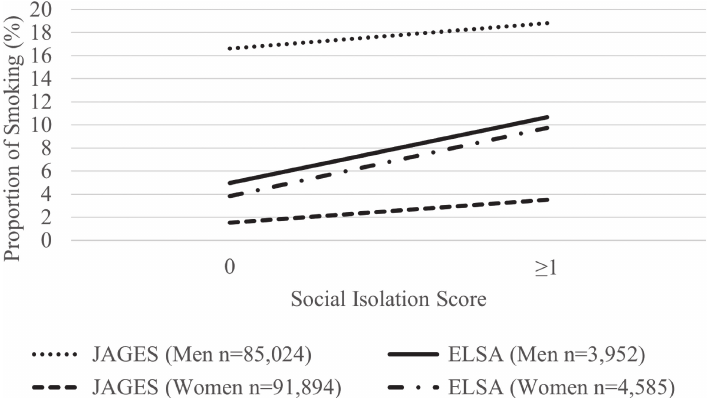
Figure 1. Social isolation and the proportion of current smokers in ELSA and